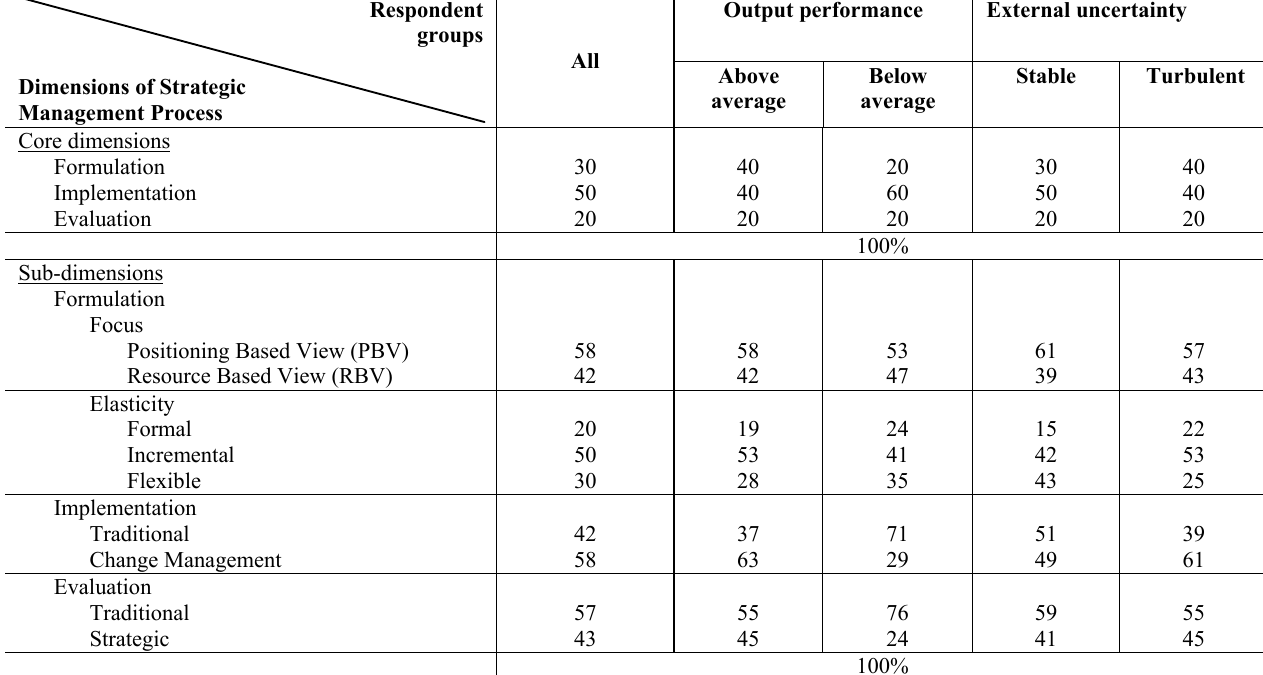
Table 1: Dimensions of the strategic management